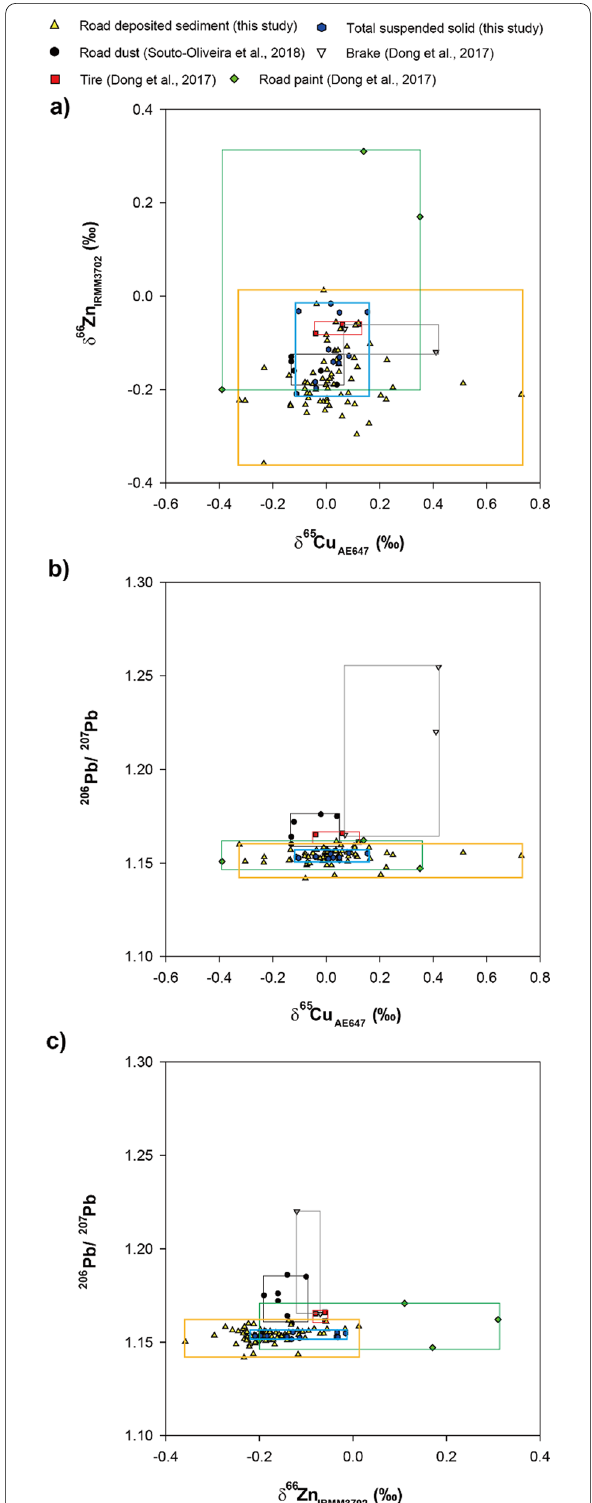
Fig. 7 Multi-isotope diagrams of this study and other literature data using δ 65 Cu AE647 vs δ 66 Zn IRMM3702 ( a ), δ 65 Cu AE647 vs 206 Pb/ 207 Pb ( b ) and δ 66 Zn IRMM3702 vs 206 Pb/ 207 Pb ( c